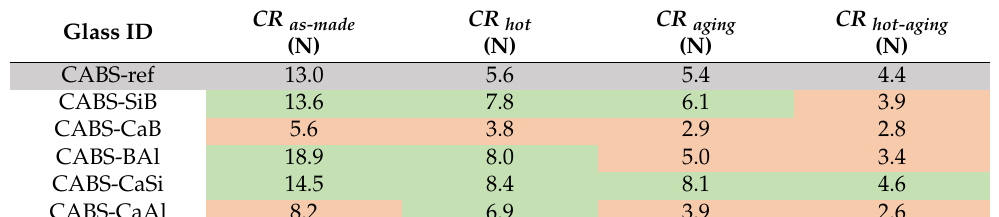
Table 5. Crack resistance (CR) for Vickers indentation of the as-made, hot-compressed, humid-aged, and hot-compressed/humid-aged CABS glasses. Coloring indicates CR value of reference glass (grey), and decreasing CR relative to reference (red). The error in CR was within 15%. CR as-made Glass ID (N)